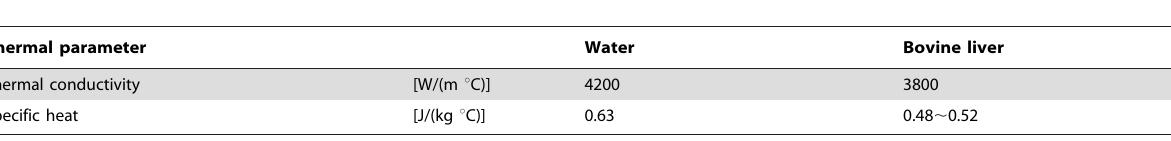
Table 3. Thermal parameters of the media of